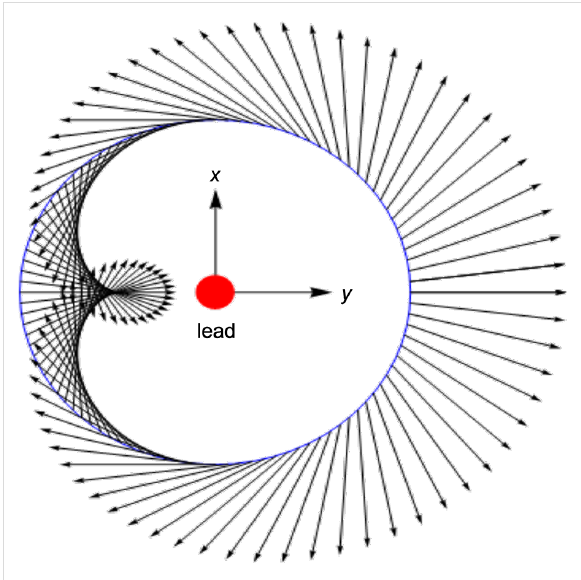
Figure 2: Pattern in the y – z -plane of the electric field produced by a pure spin current flowing in the lead, parallel to the x -axis, represented here by the disk at the origin. The magnetic field is along the y -axis.